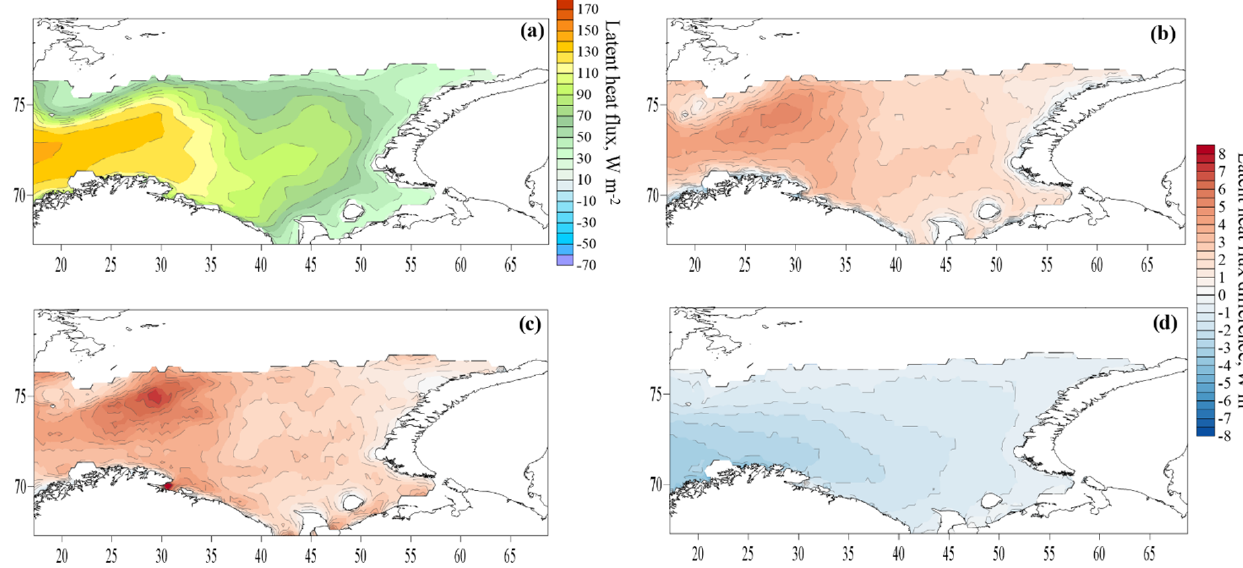
Figure 19. Mean latent heat flux in experiment C55 (a) and the flux difference in experiments T1–C55 (b) , O2–C55 (c) and D3–C55 (d) during simultaneous storm wave events and cold-air